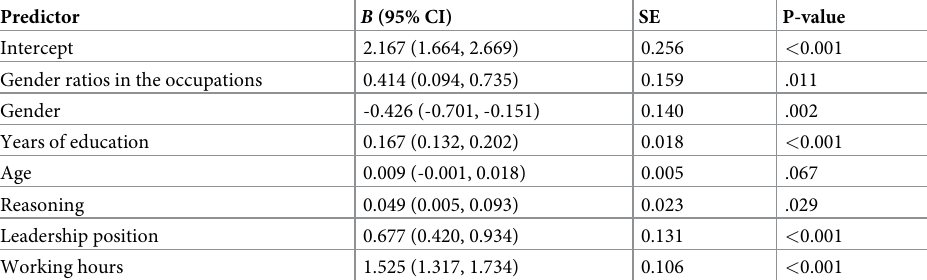
Table 2. Predictors of income: Regression results for the additive